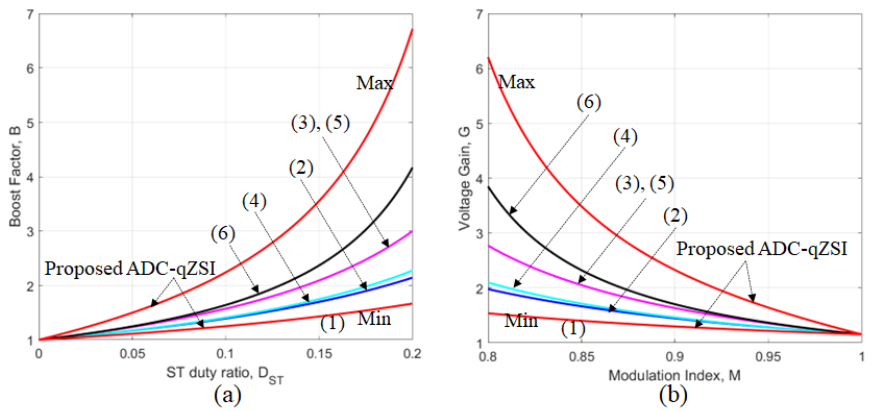
Figure 6. Comparison of boost factor and voltage gain: ( a ) ST duty ratio vs. boost factor, ( b ) modulation index vs. voltage gain. (1) DqZSI [8], (2) SL-qZSI [18], (3) rSL-qZSI [19], (4) ASC-EqZSI [20], (5) ASC/SL-qZSI [21], (6) HG-qSBI [22].